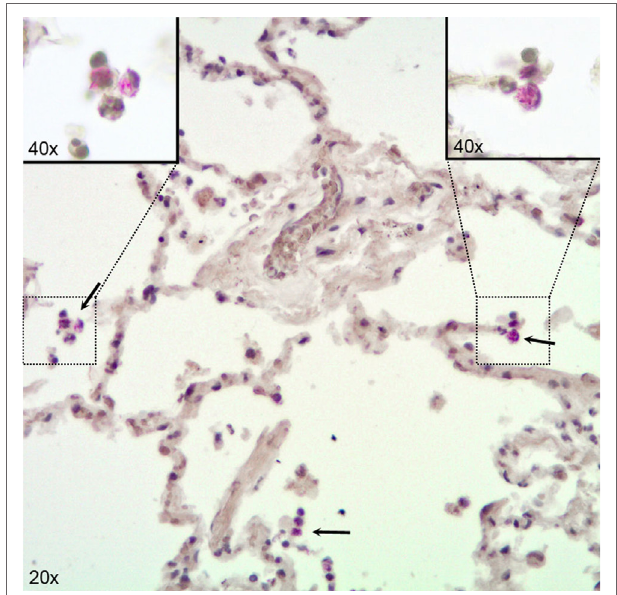
FigUre 1 | Immunohistochemical visualization of Mycobacterium tuberculosis in alveolar macrophages (AM) in infected human lung tissue. Lung tissue formalin fixed 24 h after infection with H37Rv. Stained for acid fast bacilli by the Ellis and Zabrowarny technique (purple). Arrows point to AM containing bacilli, with insets showing higher magnification of selected